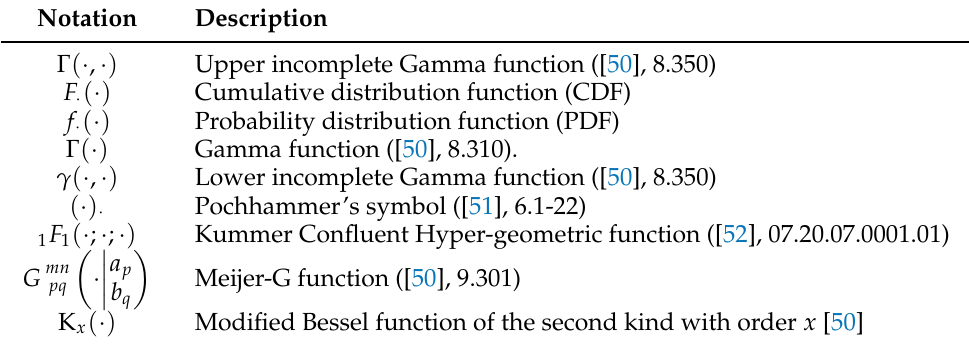
Table 1. List of notations.